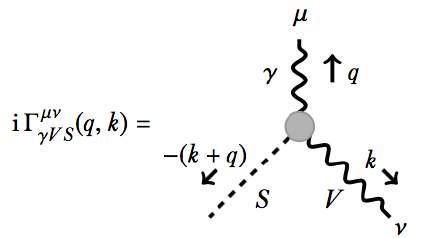
Figure 1 . E(cid:11)ective vertex of a photon, scalar S , and (in general massive) vector V computed from the inner